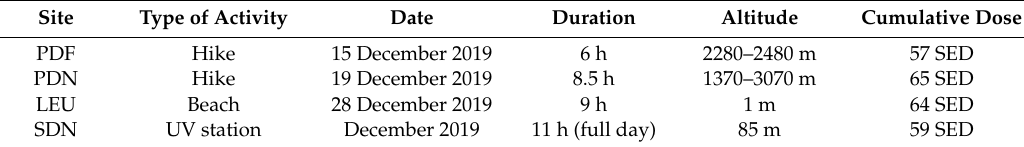
Table 2. Summary of the experiment results, with the associated cumulative